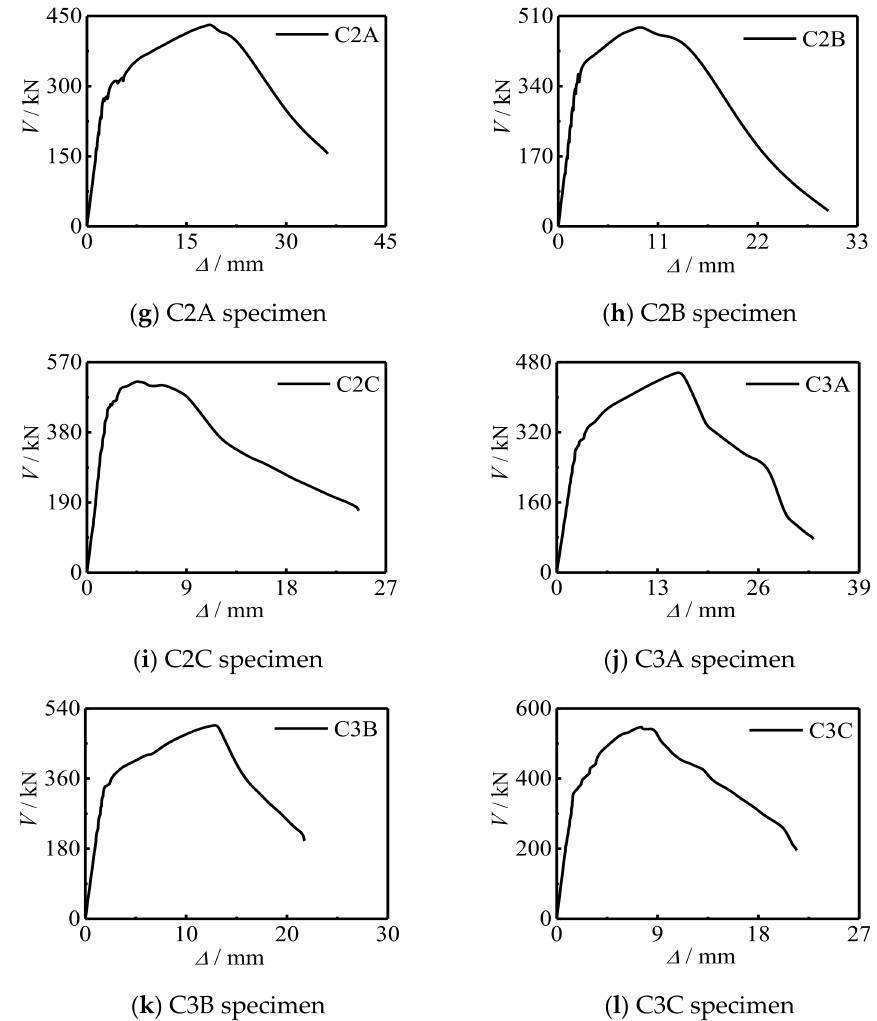
Figure 6. V - ∆ curves of specimens.